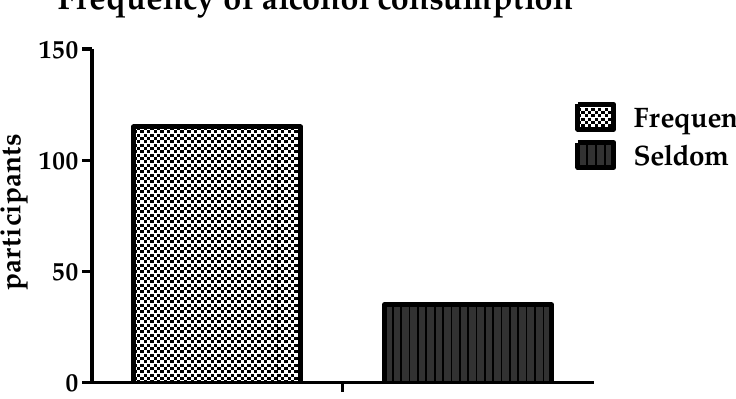
Figure 6. Frequency of alcohol consumption among the participants.